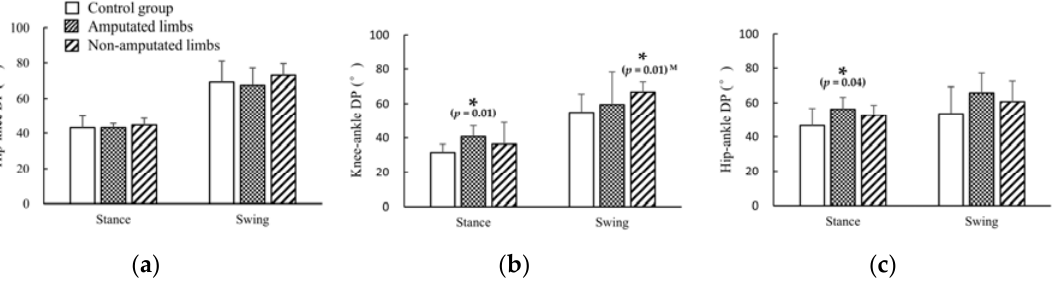
Figure 5. Comparison of the deviation phase (DP): ( a ) hip–knee, ( b ) knee–ankle, ( c ) hip–ankle. * indicates a significant difference relative to the control group ( p < 0.05). * indicates a significant di ff erence relative to the control group ( p < 0.05).